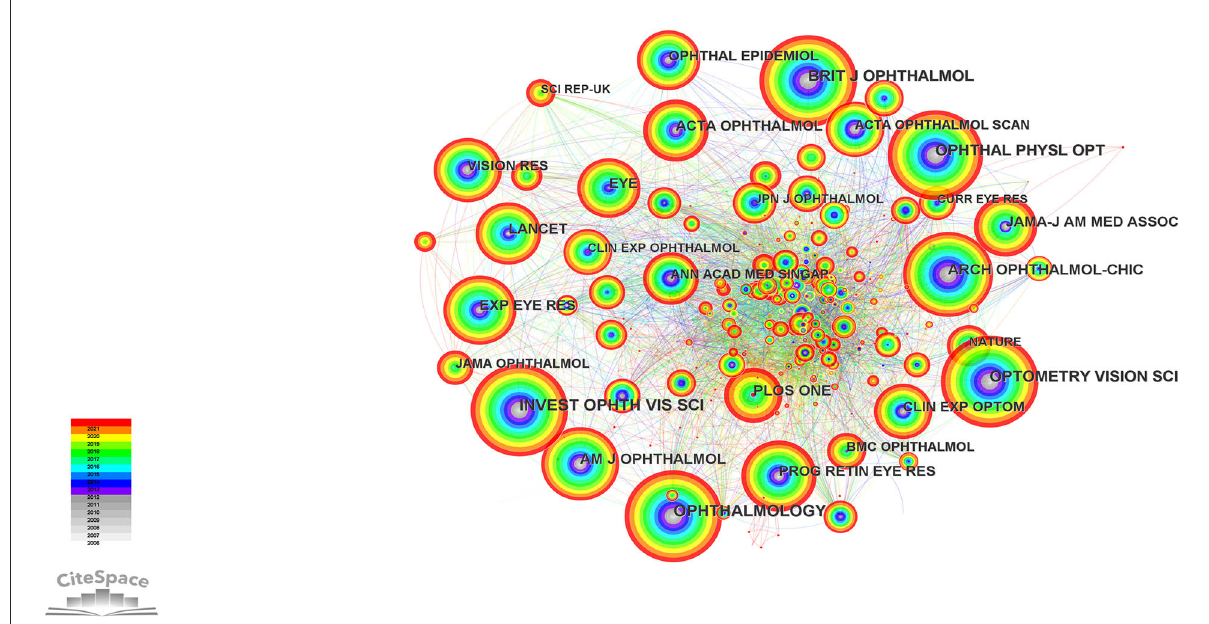
FIGURE9 Co-citation analysis of journal on the relationship between outdoor activities and myopia from 2006 to 2021.